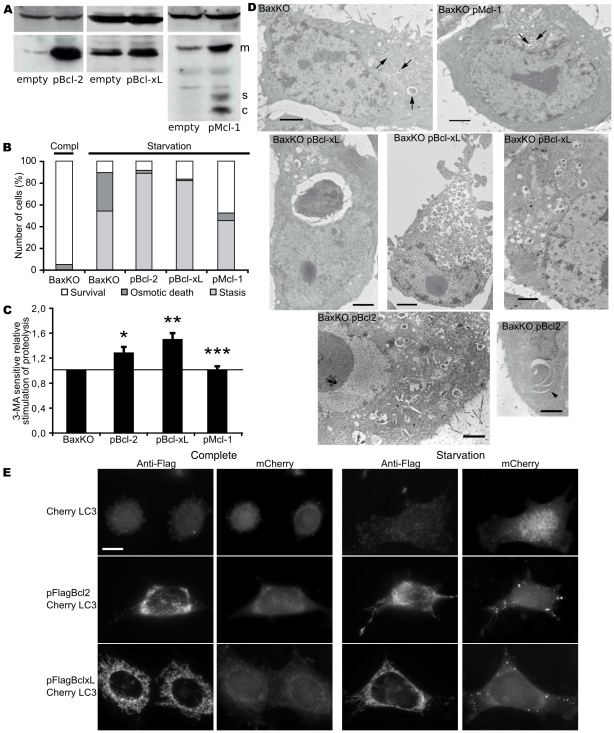
Bcl-2 and Bcl-xL stimulate survival autophagy while Mcl-1 does not.(A) Western blots of cells transfected with an empty vector, or vectors encoding Bcl-2 or Bcl-xL or Mcl-1. 50 µg of protein extracts were analysed on a 12% SDS-PAGE. Mcl-1 was detected as a mature protein (m), a spliced variant (s) and a caspase-cleaved product (c). (B) Morphometric analyses of HCT116-BaxKO-derived stable cell lines: cells were plated in complete media and time-lapse video microscopy started when cells were transferred to HBSS (starvation) or not (complete). A minimum of 700 cells were analysed in at least triplicate experiments. (C) Relative stimulation of starvation-induced 3-MA-sensitive degradation of long-lived proteins in HCT116-BaxKO cell lines transfected or not with Bcl-2 or Bcl-xL or Mcl-1. Cells were chased for 6 hours in HBSS or HBSS + 3-MA. The 3-MA sensitive activity measured in HCT116-BaxKO cells was set at 1 and results represent the 3-MA sensitive activities of each cell line relative to that found in untransfected cells. Data are the mean (±s.d.) of at least 3 independent experiments. Student test was used for statistics significance of the results compared to untransfected cells: (*)p = 0,010 (**)p = 0,001 and (***)p = 0,479. (D) TEM of HCT116-BaxKO cells over-expressing Bcl-2 or Bcl-xL or Mcl-1 after 6 hours of starvation in HBSS. Arrows point at degradative autophagosomes. Scale bar: 2 µm. (E) 24 h after transfection either with mCherryLC3 alone, or with mCherryLC3 and Flag-Bcl-xL or Flag-Bcl-2, BaxKO MEF cells grown in complete medium or starved for 6 hours were fixed. Immonocytochemistry reveals Flag-tagged constructs (green). Pictures are representative of at least 4 independent experiments. Scale bar: 10 µm.